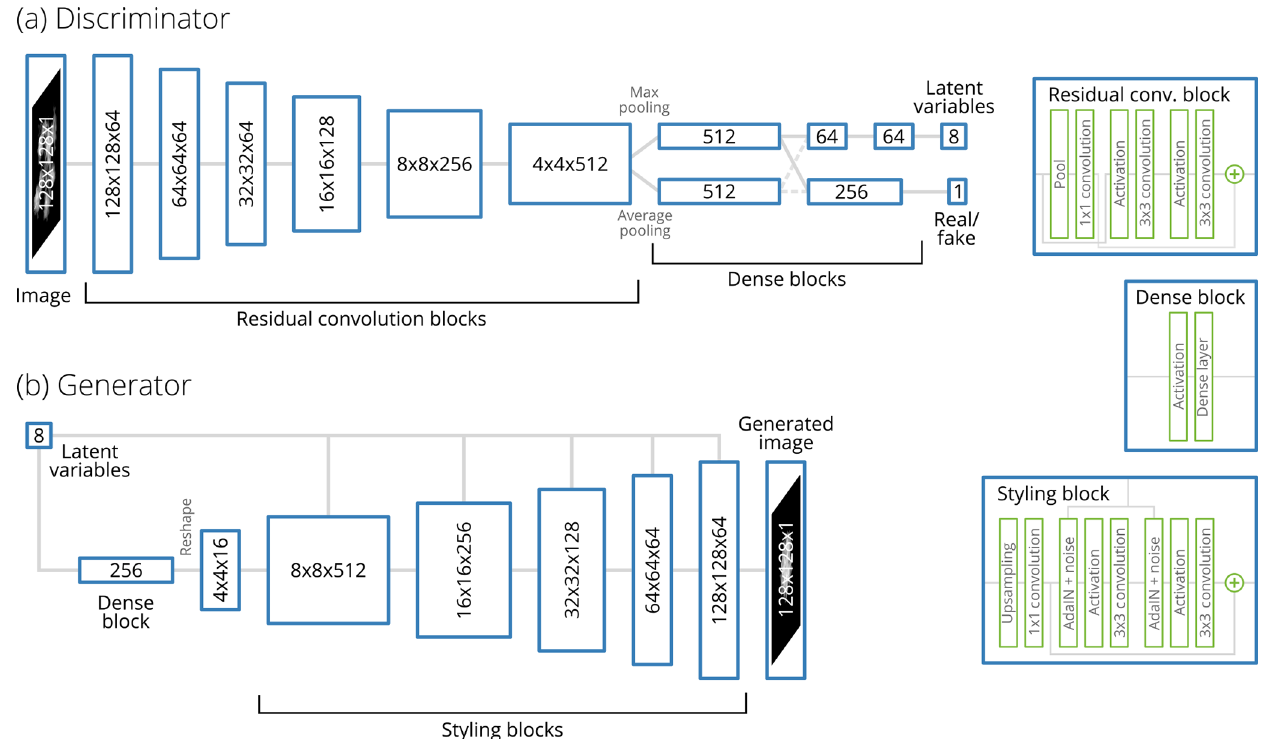
Figure 1. Outlines of the architectures of the (a) discriminator and (b) generator networks. The numbers on the blocks denote the size and number of feature maps; for example, 16 × 16 × 256 indicates 256 feature maps of 16 × 16 pixels each. The number of features for each layer was determined by adapting network architectures used in earlier GAN studies and then tuning the sizes to achieve a reasonable compromise between performance and computational